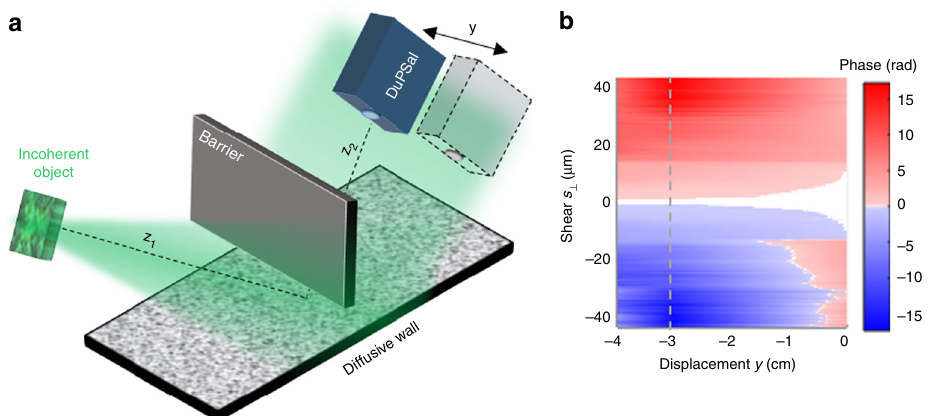
Fig. 4 Distance recovery from coherence measurements. a The object-to-wall distance is z 1 = 80cm, the angle of incidence is θ = 80°, and the complex spatial coherence function of the scattered fi eld is measured at z 2 = 100 cm from the diffusing wall. The coherence detector (DuPSaI) was translated up to 4 cm from the optical axis as indicated. b Two-dimensional phase map of the measured coherence function corresponding to different transversal position of DuPSaI, the phase measurement that was used to recover the total distance to the target is represented by the dotted